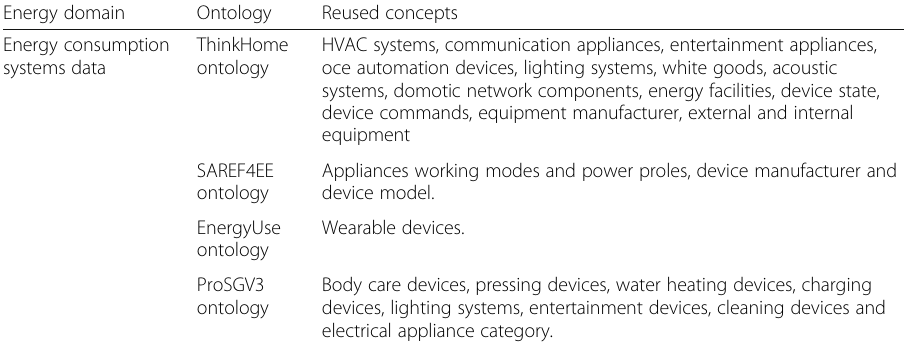
Table 3 Example of Reused Ontologies and Concepts (Cuenca et al. 2017)